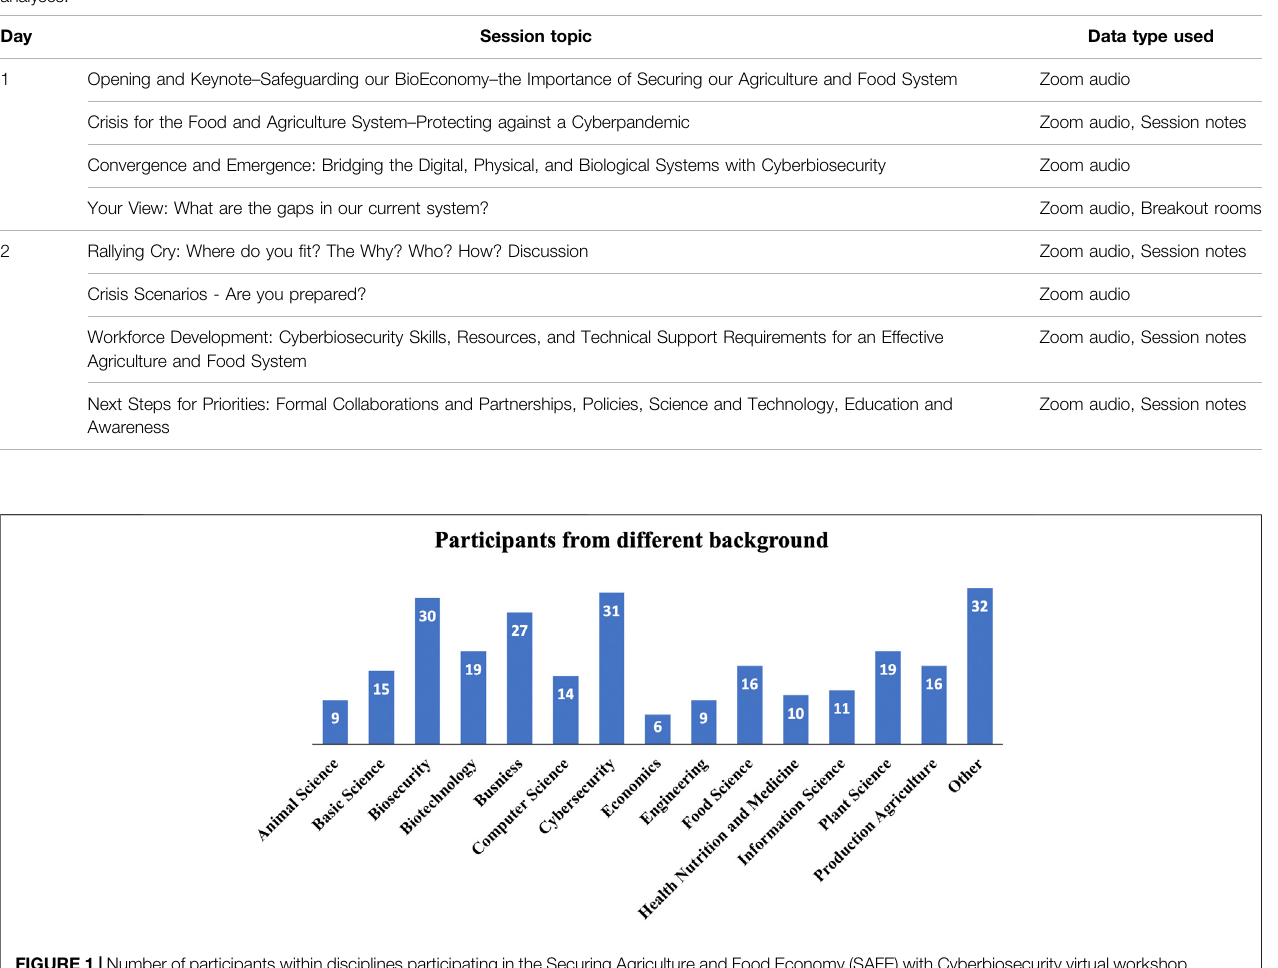
Frontiers in Bioengineering and Biotechnology |